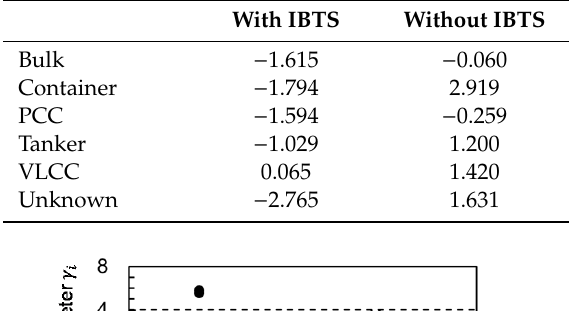
Figure 11. Relationship between ship type and individual parameters for vessels ( a ) with IBTS and ( b ) without IBTS. PCC and VLCC stand for pure car carrier and very large car carrier, respectively. Table 4. Mean of individual parameter r i for various ship types. PCC and VLCC stand for pure car carrier and very large car carrier, respectively. With IBTS